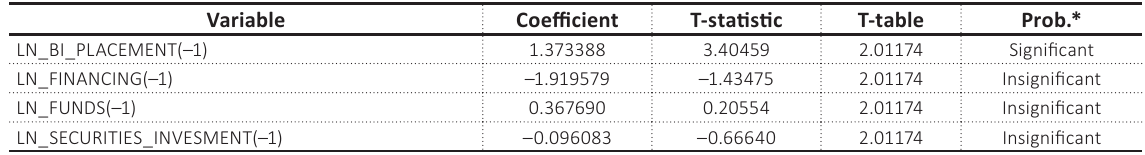
Table 6. VECM long-run test